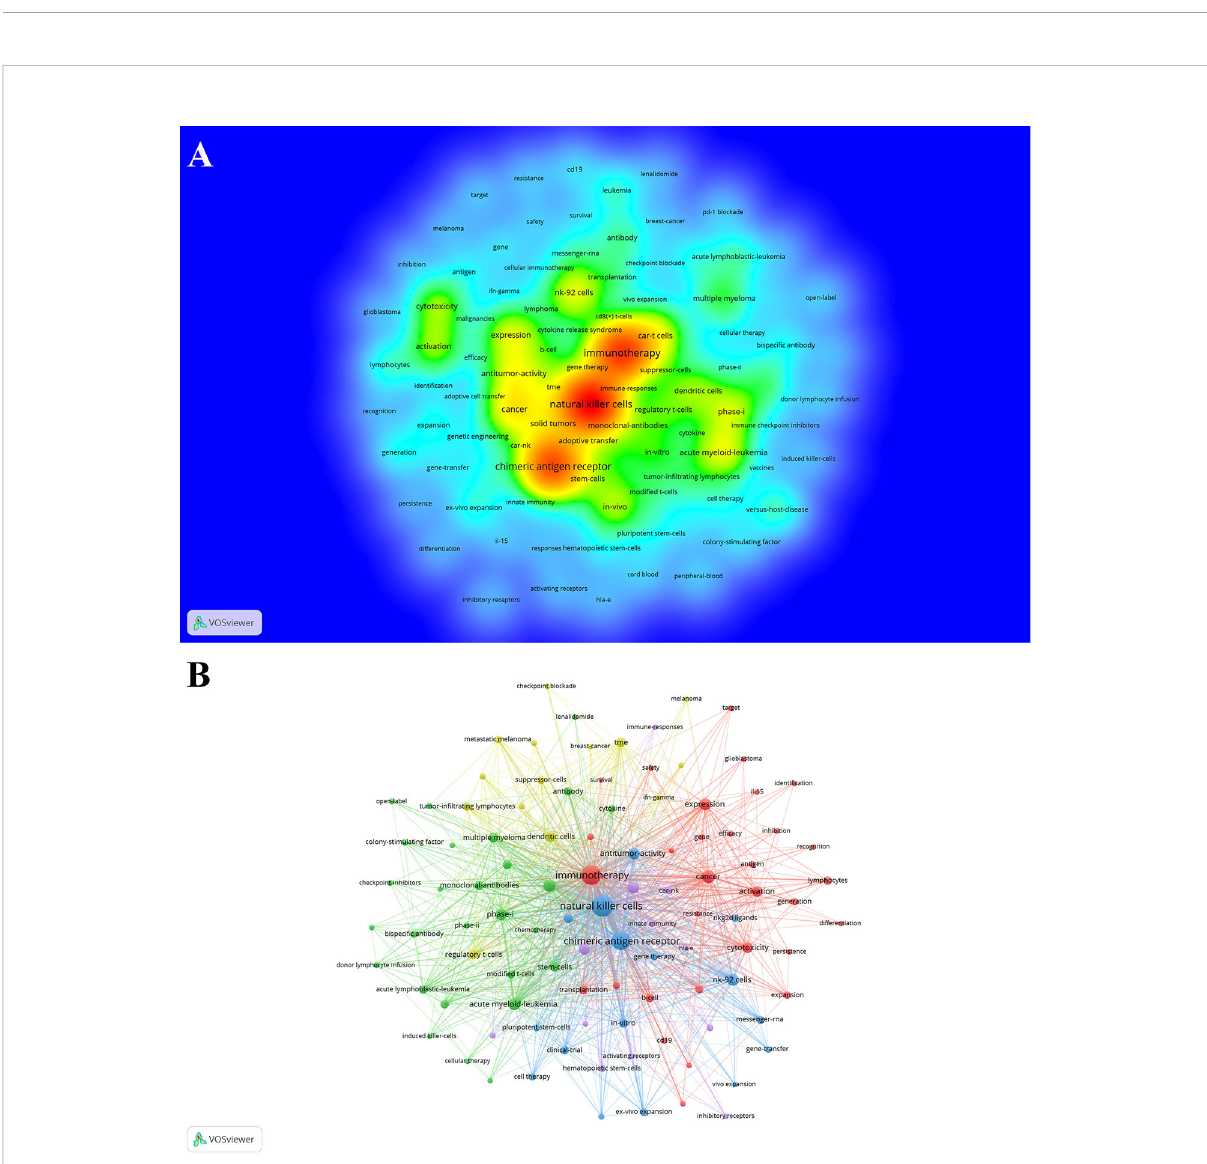
FIGURE 6 The co-occurrence density map (A) and network (B) of keywords involved in CAR-NK cells. Minimum number of occurrences of keywords ≥